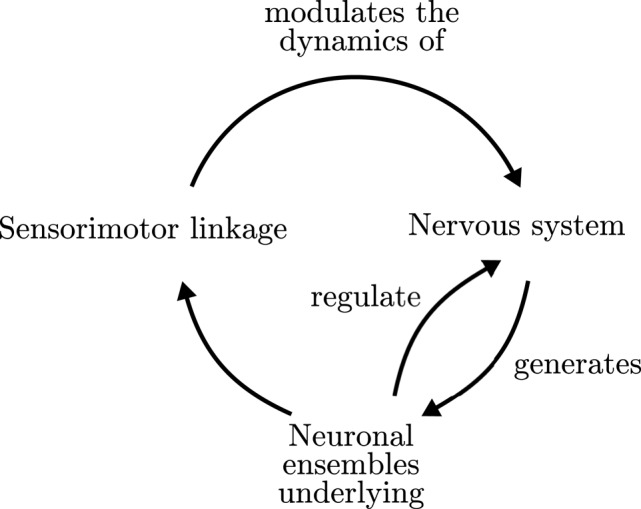
Organizational closure of the nervous system. Adapted from Varela (1997).